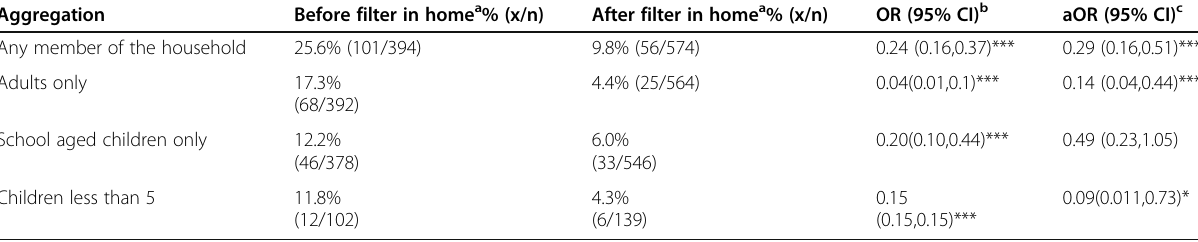
Table 3 Prevalence of self-reported diarrhea by home filter status Aggregation